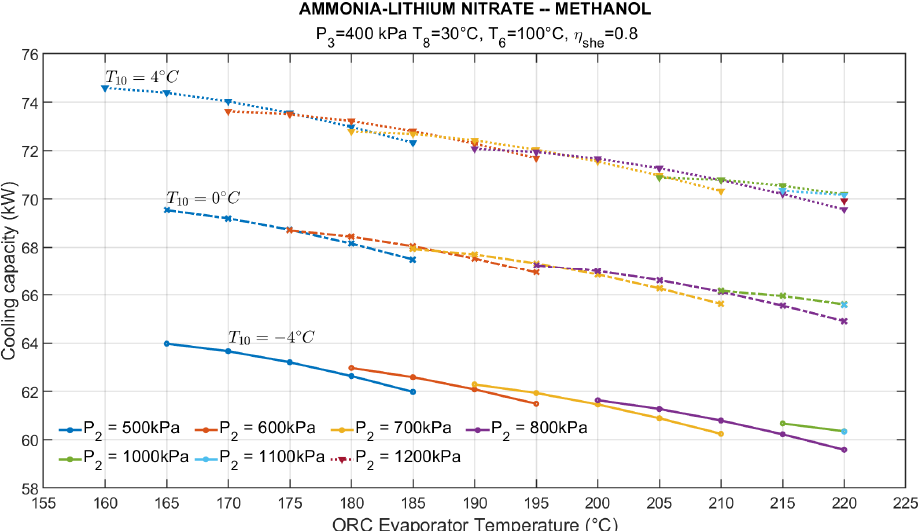
Figure 11. NH 3 -LiNO 3 –CH 3 OH effect of heat source and cooling temperatures on cooling load.